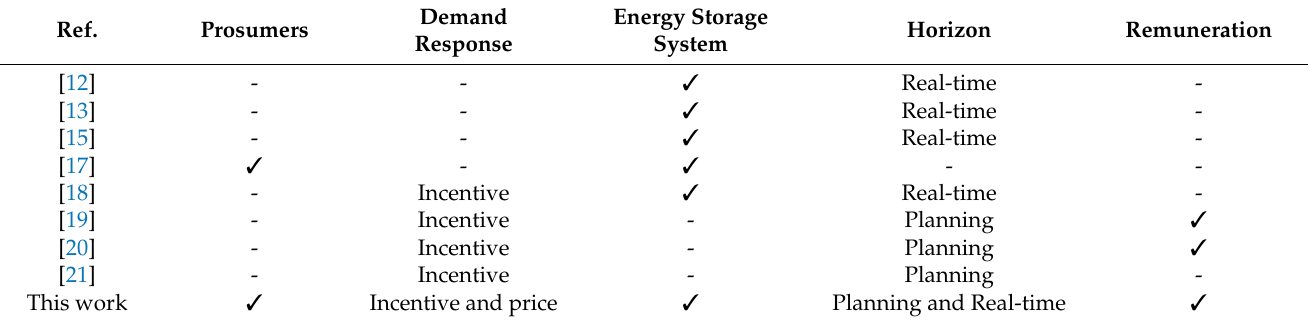
Table 1. The literature review summarized ( (cid:51) means that the topic is covered by the